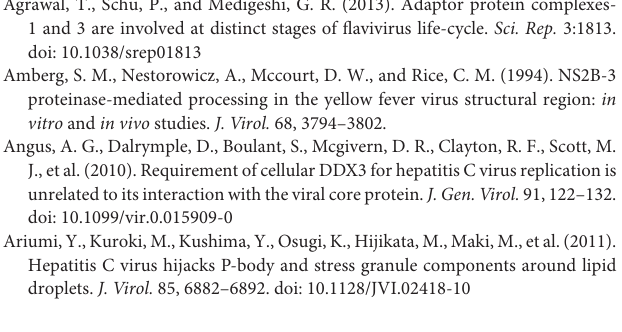
Figure S2 | Interaction between capsid and DDX3X is not mediated via RNA. Huh-7 cells were infected with DENV at an MOI of 5. At 24h pi mock and DENV-infected Huh-7 cell lysates were prepared and treated with RNAse prior to immunoprecipitation. DDX3X was immunoprecipitated from total lysates (untreated) and RNAse-treated lysates using DDX3X antibody at 4 ◦ C. Total lysate and immunoprecipitated proteins were detected by western blots. Figure S3 | Deletion constructs of capsid. (A) Graphical representation of His-capsid deletion constructs. (B) HEK293T cells were transfected with plasmids encoding various capsid constructs. Total lysates were prepared at 24h p.t. and